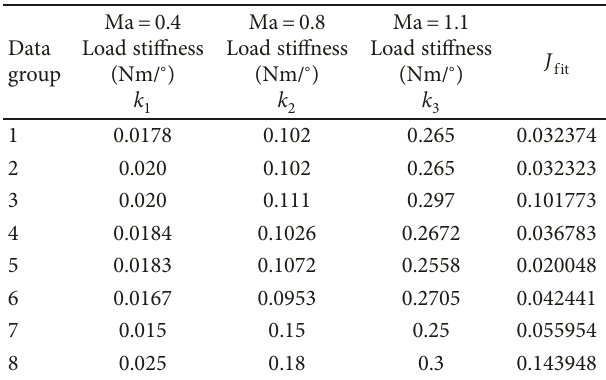
Table 3: Load sti ff ness for a fi xed Mach number after